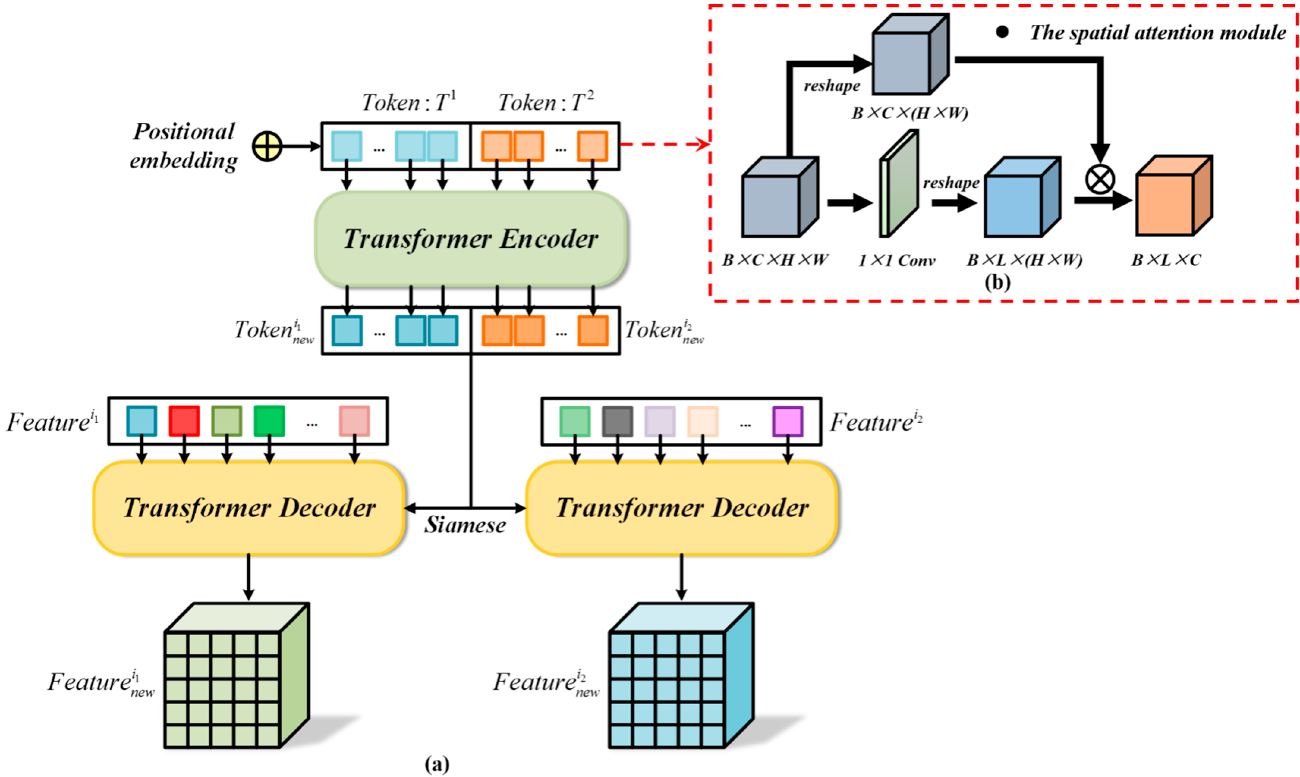
Figure 6. ( a ) The details of the transformer module. ( b ) The details of the spatial attention module.